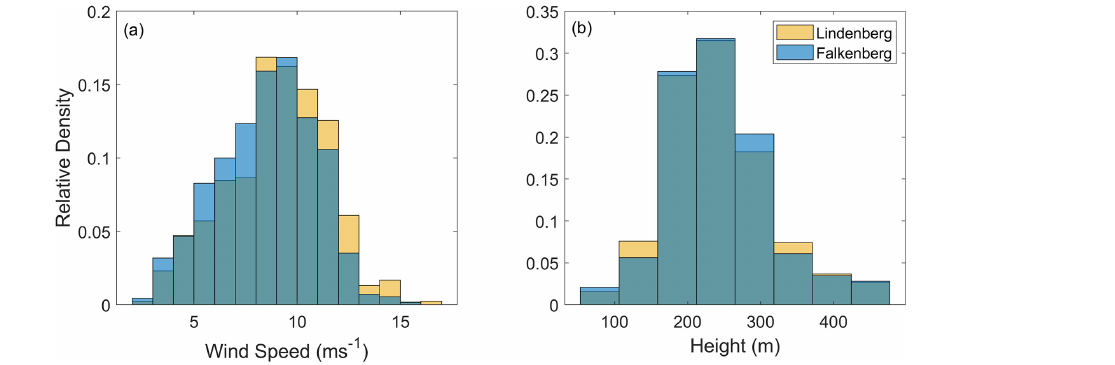
Figure 5. NLLJ core wind speed (a) and height (b) in Falkenberg (blue) and Lindenberg (yellow).